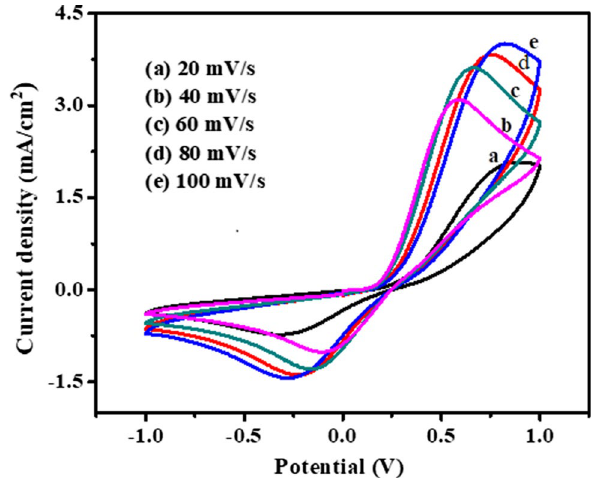
Fig. 7 Plot of current density versus applied voltage in 0.1 M KCl solution containing 10 mM NaNO 3 at different scan rates ranging from 20 to 100 mV s